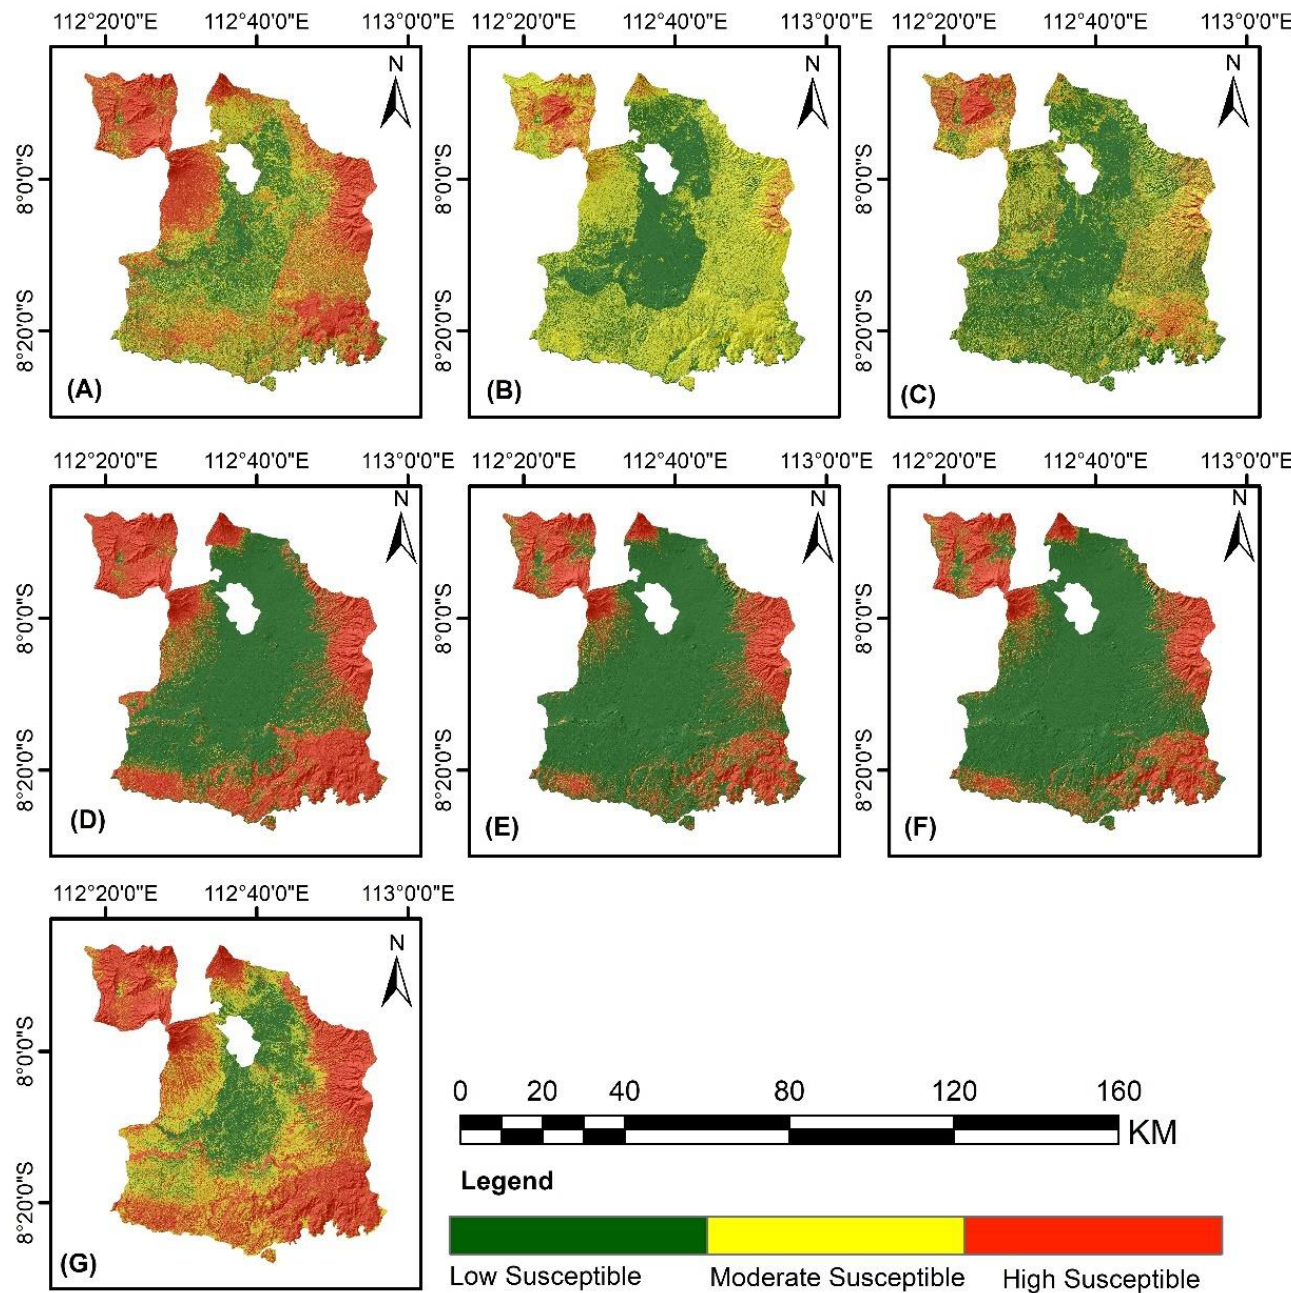
Figure 5. Landslide susceptibility modeling result of 7 models. ( A ) KNN 50:50 model. ( B ) KNN 60:40 model. ( C ) KNN 70:30 model. ( D ) NB 50:50 model. ( E ) NB 60:40 model. ( F ) NB 70:30 model. ( G ) RF 70:30 model.